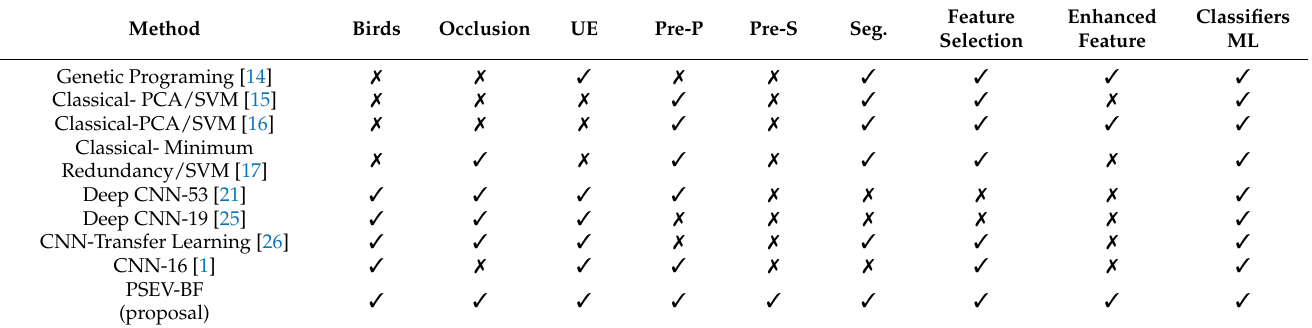
Table 1. A comparison between the principal topics of the methodology of the related works. Method Birds